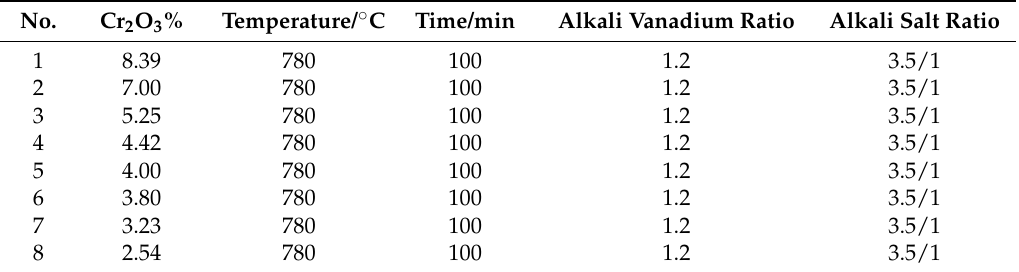
Table 3. Scheme of the influence of chrome oxide on the vanadium conversion experiment.